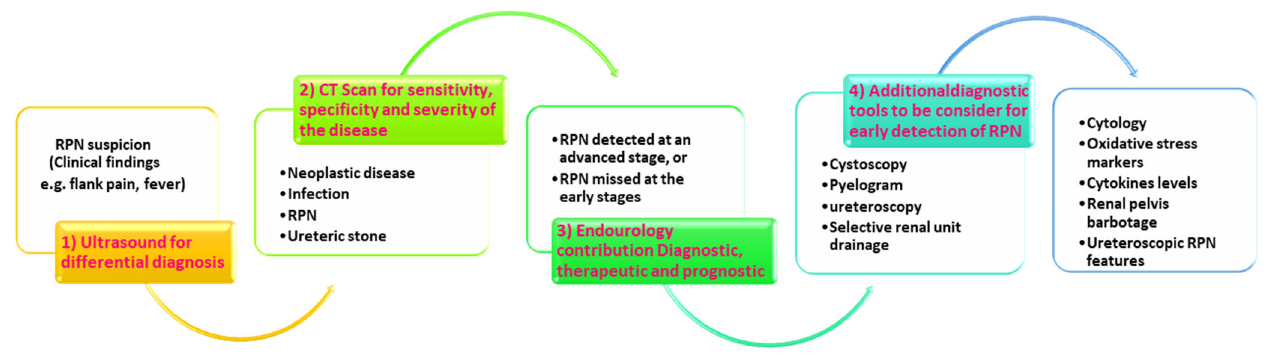
Figure 5. Emerging diagnostic paradigm shift for RPN diagnosis. Several approaches could be considered when investigating RPN. (1) Ultrasound is used for differential diagnosis which could detect advanced RPN or other diseases such as ureteric stone; (2) CT scan is more sensitive and mostly specific in detecting kidney diseases but early stages of RPN can still be missed at this point; (3) endourological approach could be more determinant during an emergency (hematuria) or elective procedure; (4) additionally, other diagnostic assays could be investigated as reliable methods that could assist in detecting and diagnosing the RPN early and allow sufficient time to prevent further damage to the kidney.